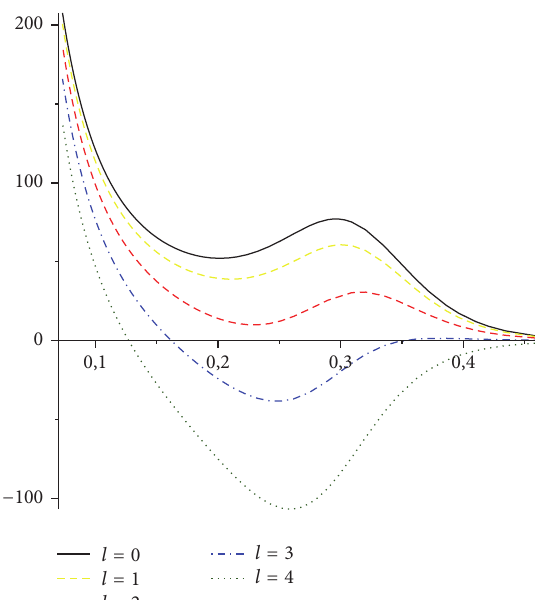
Figure 4: The potential 𝑉 in function of the tortoise coordinates for the fixed values of 𝛼 0 = 0.677 , 𝑀 = 1 , and 𝜇 = 0 .